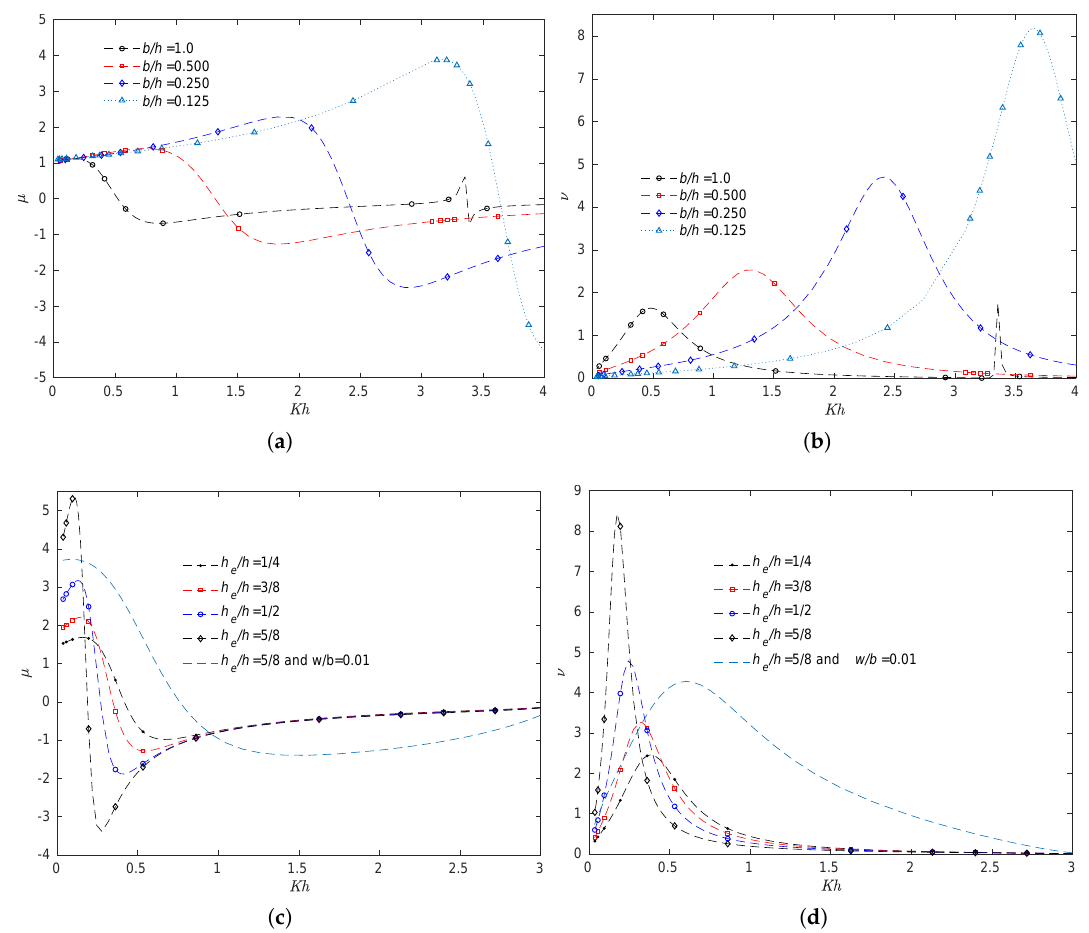
Figure 9. The radiation susceptance and radiation conductance coefficients versus Kh . ( a ) The radiation susceptance coefficient for various wall to front barrier spacing ratios b / h with h a / h = 0.125 and w / b = 1.0. ( b ) The radiation conductance coefficient for various wall to front barrier spacing ratios b / h with h a / h = 0.125 and w / b = 1.0. ( c ) The radiation susceptance coefficient for various step to bottom ratios h e / h with h a / h = 0.125, b / h = 1.0 and w / b = 1.0. ( d ) The radiation conductance coefficient for various step to bottom ratios h e / h with h a / h = 0.125, b / h = 1.0 and w / b =